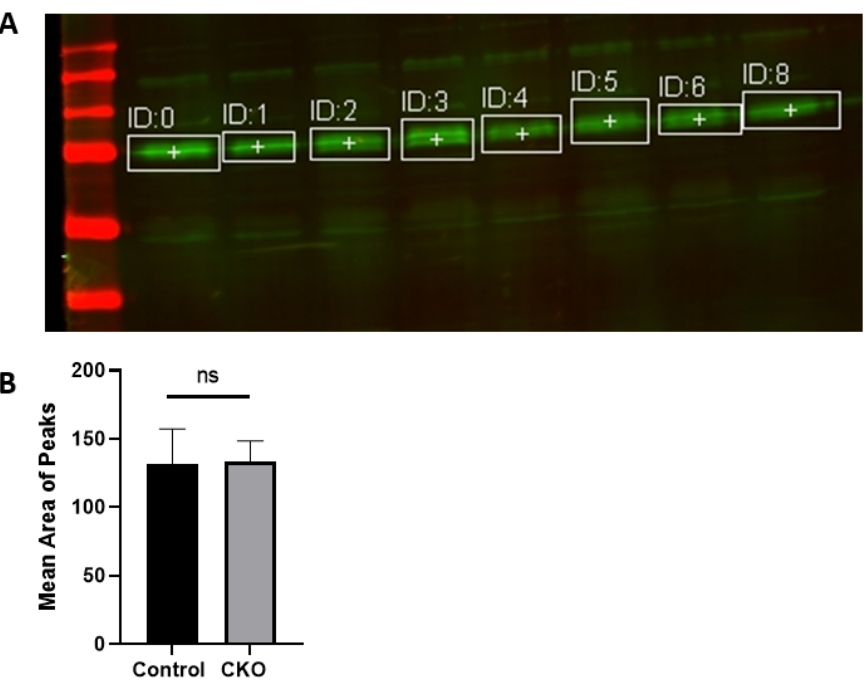
Figure 1. Validation of the CKO model by crossing tamoxifen-inducible CamK2a Cre-ERT2 mice with MEN1 floxed mice. ( A ) Validation was achieved through WB for comparing menin protein in the CKOs and control animals. The WB analysis of C-menin expression in the hippocampus at P54 with age matched mice. The C-menin expression for the controls is marked in the lanes ID:0, ID:1, ID:2, and ID:3. The C-menin expression for the menin CKO is marked in the lanes ID:4, ID:5, ID:6 and ID:8. ( B ) Summary data, showing no difference in the mean area of the peaks between the controls and the experimental groups. Data represent the mean ratio ± SEM. n = 4. Statistical significance (Mann–Whitney U test) ns p > 0.05.